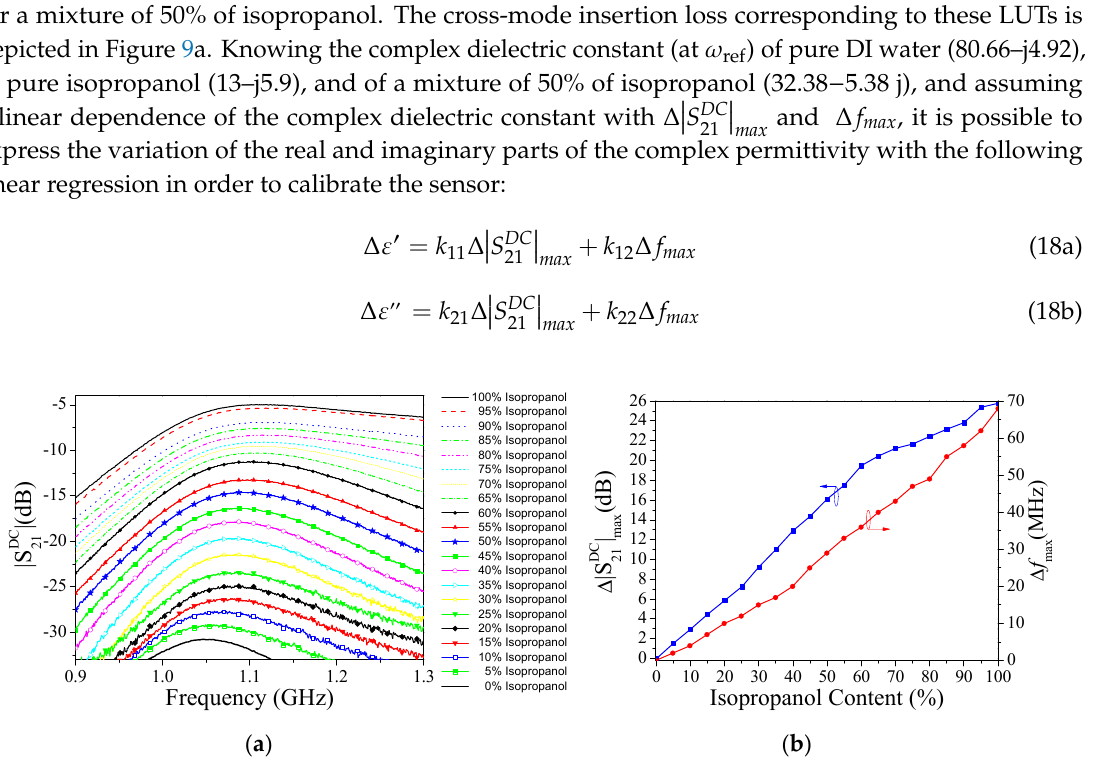
Figure 9. ( a ) Cross-mode insertion loss for different mixtures of isopropanol and deionized (DI) water ( b ) dependence of Δ | S 21DC | max and Δ f max with isopropanol content.